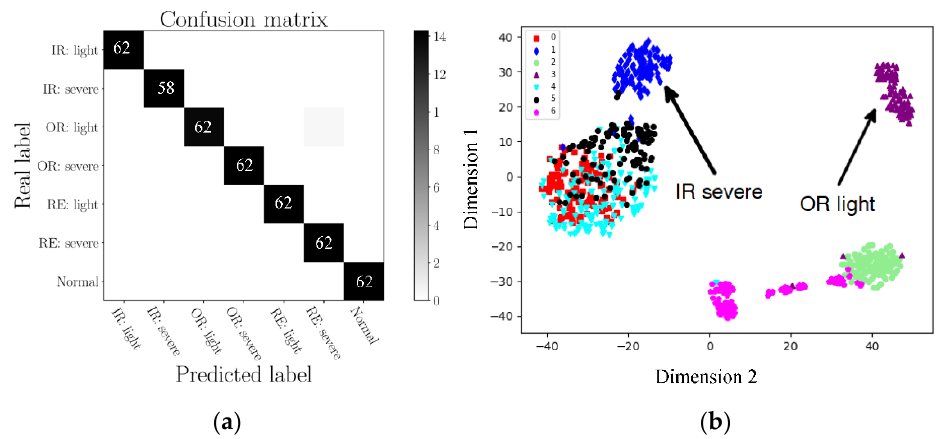
Figure 10. Identification of difficult classification categories. ( a ) Confusion matrix of IMS, ( b ) t-SNE representation of IMS. Table 7. 1D-CNN performance when only using classes that are difficult to classify.